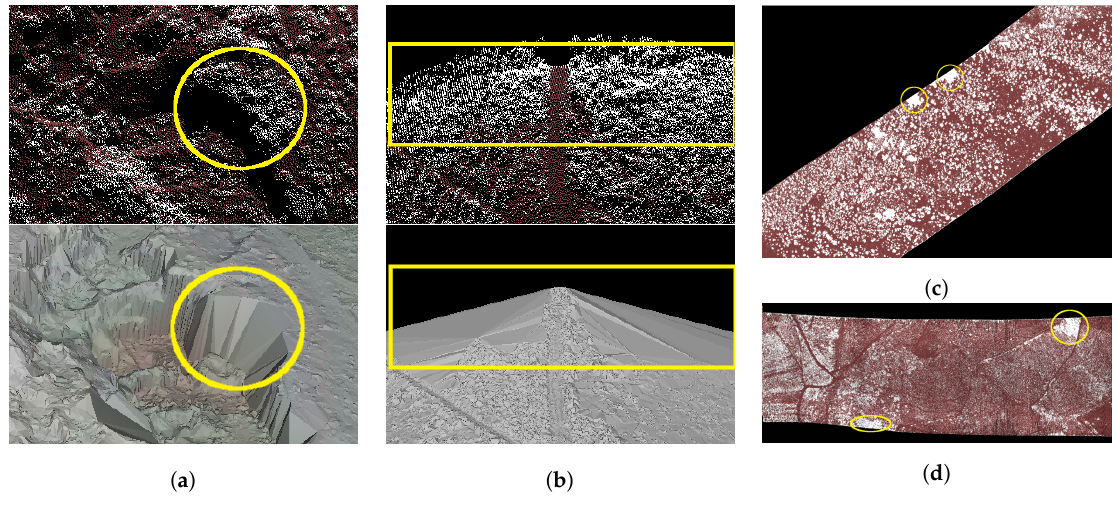
Figure 12. Visible errors highlighted in yellow. Table 2. Point clouds for the qualitative evaluation.